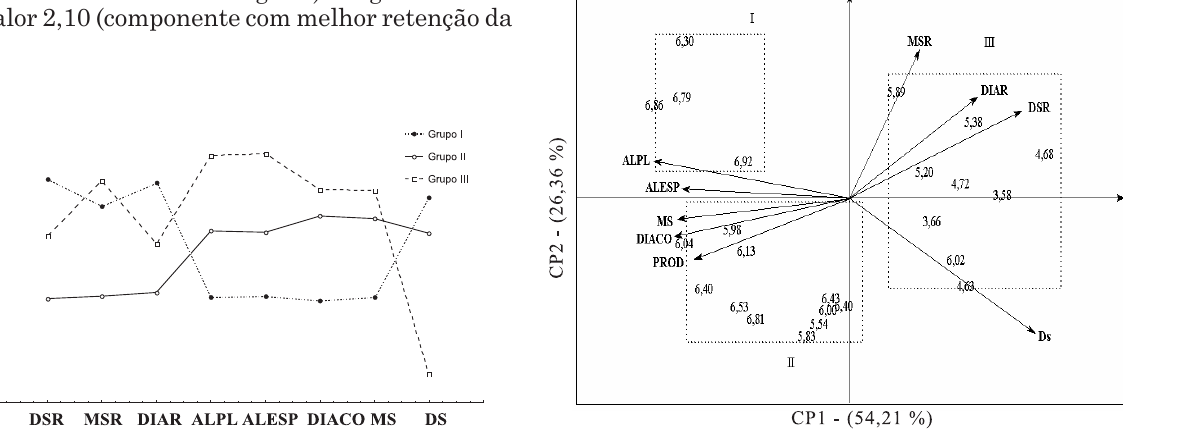
Figura 3. Médias padronizadas das características agronômicas do milho e densidade do solo para cada grupo, segundo análise de agrupamentos não-hierárquica k-means . DSR: densidade do comprimento radicular, MSR: matéria seca das raízes, DIAR: diâmetro radicular, ALPL: altura de plantas, ALESP: altura de inserção da espiga, DIACO: diâmetro do colmo, MS: matéria seca das plantas e DS: densidade do